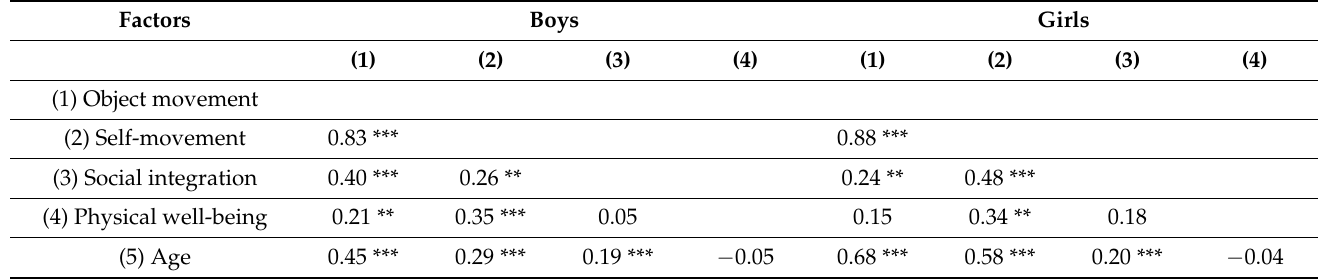
Table 7. Intercorrelations between the variables in model 4 (subsample